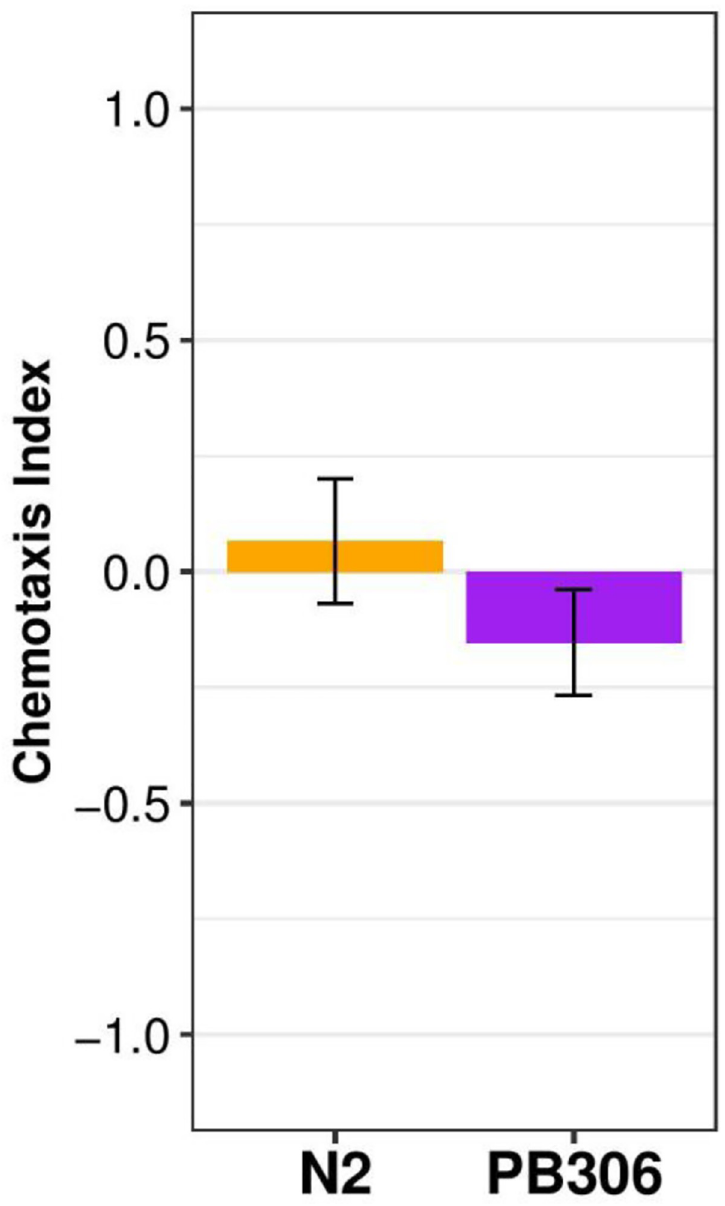
Fig 3. C . elegans N2 and PB306 strains do not respond to P . scaber gas secretions. The orange bar (left) represents the chemotactic indices of N2 adults to P . scaber gas secretions from at least three independent experiments. The purple bar (right) represents the chemotactic indices of PB306 adults to P . scaber gas secretions from at least three independent experiments (see S5 Table for p values, n = 50–100 animals per replicate). Error bars are standard